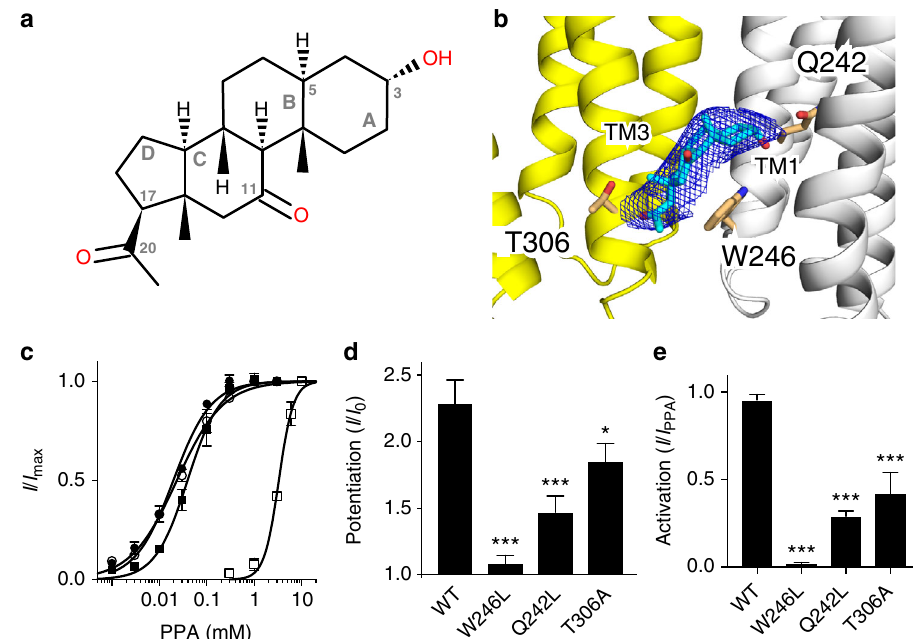
Fig. 4 Alphaxalone binding mode in the α 1GABA A R chimera. a 2D chemical structure of alphaxalone with rings and carbon atoms labeled according to the IUPAC standard for steroids. b Crystal structure of alphaxalone (cyan) bound to a pocket lined by residues in the transmembrane domain from the principal (yellow) and complementary (white) subunits of the α 1GABA A R chimera. Alphaxalone is surrounded by the 2 F O – F C electron density map contoured at 1 σ (blue mesh). Three residues in close contact with alphaxalone are highlighted. Functional validation of the alphaxalone-binding site was performed by c activation of Xenopus oocytes expressing WT (solid circles), T306A (open circles), Q242L (solid squares) and W246L (open squares) α 1GABA A R chimeras by propylamine (PPA) with EC 50 = 20 ± 1, 23 ± 2, 39 ± 3, and 3300 ± 300 μ M, respectively; d alphaxalone (0.1 μ M) potentiation at the EC 10 concentration of PPA; e alphaxalone (3 μ M) activation normalized to EC 100 PPA activation for each construct. Error bars represent SEM ( n ≥ 3 oocytes). Statistical signi fi cance was assessed by one-way ANOVA followed by Fisher ’ s LSD post-hoc test. Asterisks indicate statistical difference from WT at p < 0.001 (***) and p < 0.05